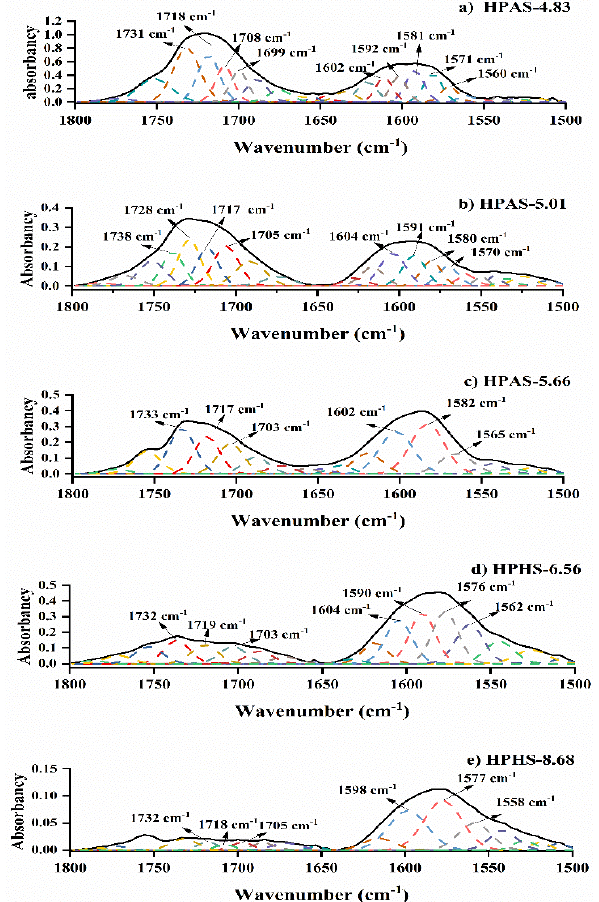
Figure 7. Fitting of peaks to the HPAS-CA films at ~1500–1800 cm − 1 : The experimental spectra are denoted by (—) and fitted peaks by (– – –).